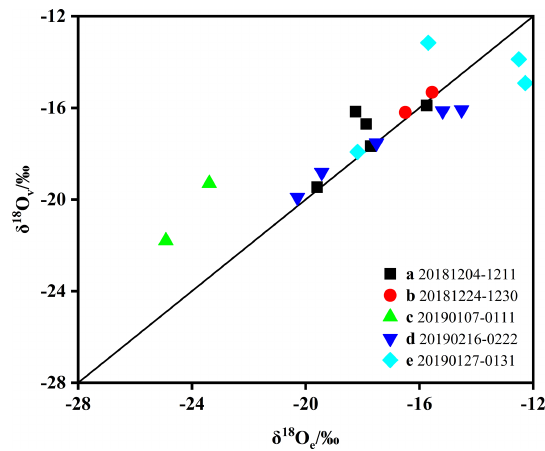
Figure 4. The relationship between observed ( δ 18 O v ) and equilib- rium ( δ 18 O e ) vapor isotopic ratios in the five typical precipitation events. The isotopic composition of the water vapor theoretically in equilibrium with that of the precipitation ( δ 18 O e ) is calculated by δ e = (δ p − ε)/α , where ε is the equilibrium enrichment factor, and α is the liquid-to-vapor equilibrium fractionation factor (Mercer et al., 2020). The solid black line is the line of